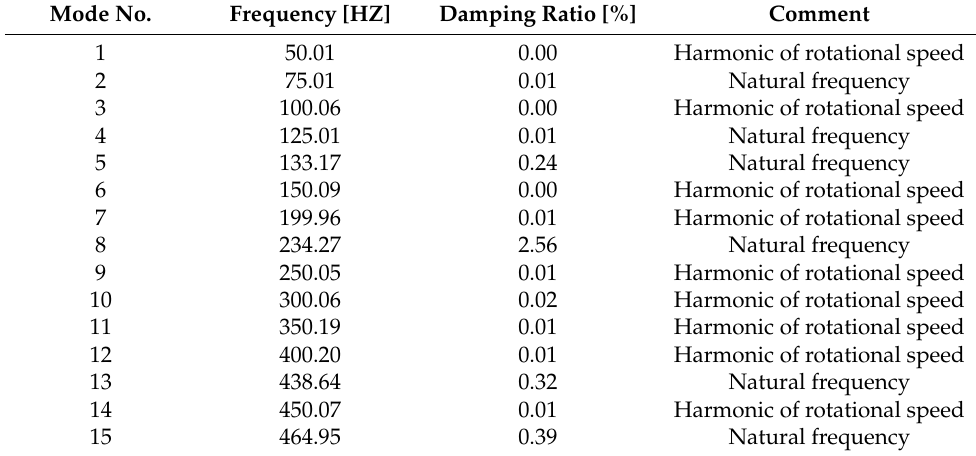
Figure 7. SUM indicator from CPD functions acquired during standard operating conditions. Modal parameter estimation is conducted in LMS Test.Lab Operational Modal Analysis module with use of the OMAX algorithm. A list of identified frequencies and damping ratios is given in Table 1. Table 1. List of identified frequencies and damping ratios from OMS in standard operational conditions. Mode No.